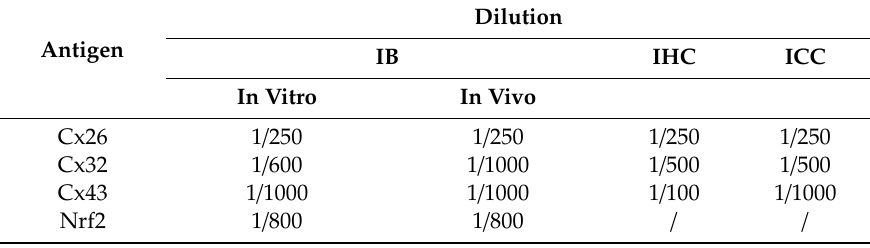
Table 2. Primary antibodies used for immunoblot (IB), immunohistochemistry (IHC) and immunocytochemistry analysis